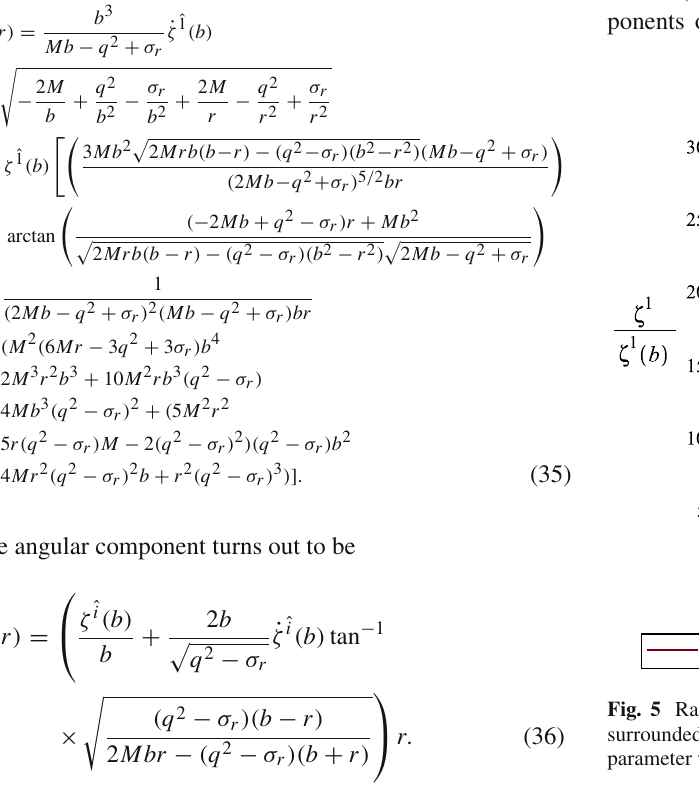
ponents of the initial geodesic deviation vector at r = b